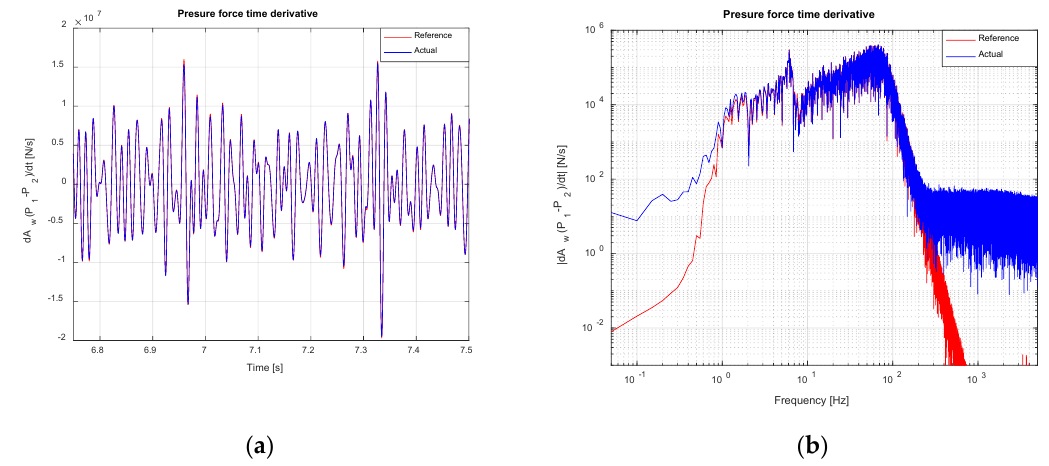
Figure 16. Pressure force time derivative tracking (noise-free scenario). TVC disabled: ( a ) Time domain; ( b ) Frequency domain.